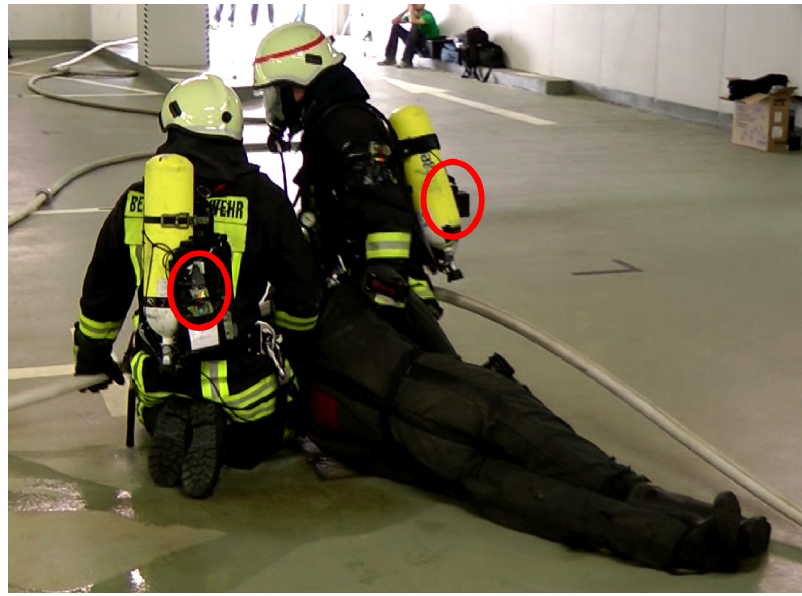
Figure 4. Captured from recordings of firefighter activities during a search and rescue mission. Sensor nodes are placed on the Landmarke transport unit on the air cylinder of the SCBA (encircled in